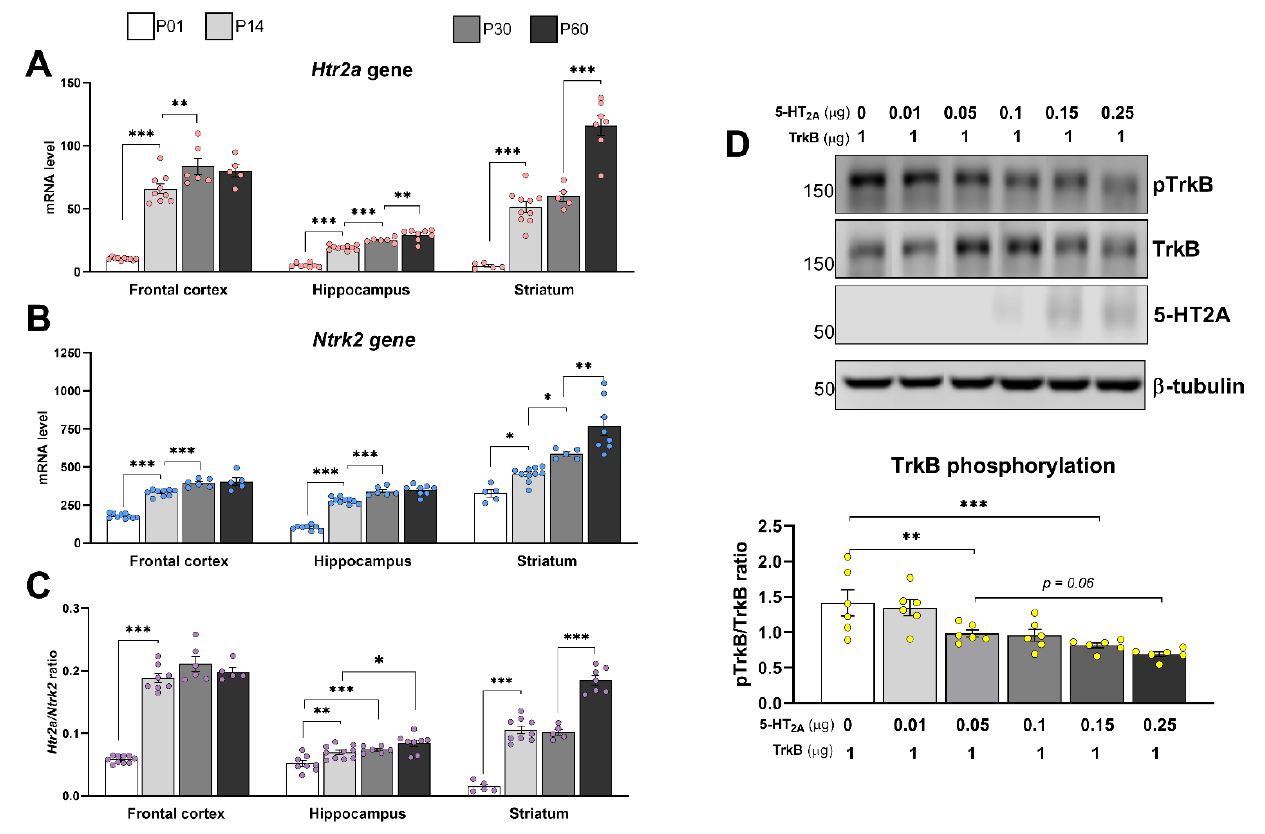
Figure 5. Expression profiles of TrkB and 5-HT 2A receptors during postnatal development. ( A , B ) Expression levels of mRNAs encoding 5-HT 2A ( A ) and TrkB ( B ) in the indicated brain regions were determined at different stages of postnatal development using real-time PCR. Gene expression is presented as the number of gene cDNA copies per 100 cDNA copies of Polr2a , used as a calibration control. ( C ) Expression ratios between 5-HT 2A and TrkB. Bars represent means ± SEM (5 ≤ n ≤ 10). * p < 0.05; ** p < 0.01 *** p < 0.001 (one-way ANOVA). ( D ) Heterodimerization exerts an inhibitory effect on agonist-independent TrkB autophosphorylation. Neuroblastoma cells were co-transfected with 1 μg of cDNA encoding the GFP-tagged TrkB receptor, together with increasing concentrations of HA-tagged 5-HT 2A receptor, followed by Western blot (WB) analysis. Lower panel: Quantification of TrkB phosphorylation. Bars show means ± SEM ( n = 6). ns: not significant, p = 0.06: an insignificant trend; ** p < 0.01, *** p < 0.001 (one-way ANOVA).